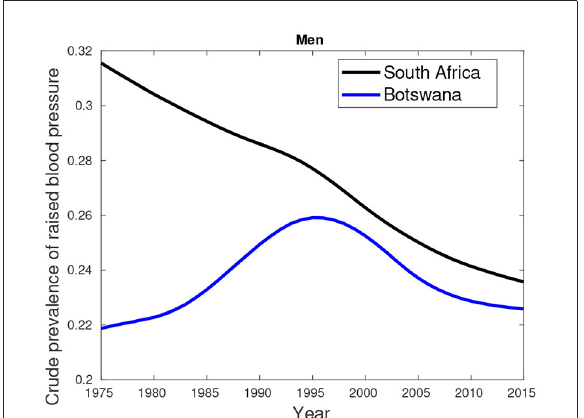
FIGURE7 Crude prevalence of raised blood pressure for male trends in Botswana and South Africa from 1975 to 2015.